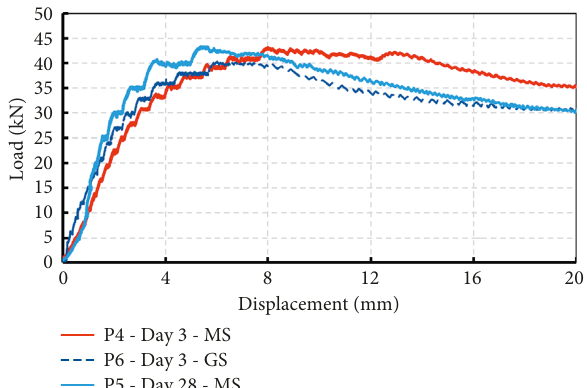
Figure 5: The test results of field model piles in tension.